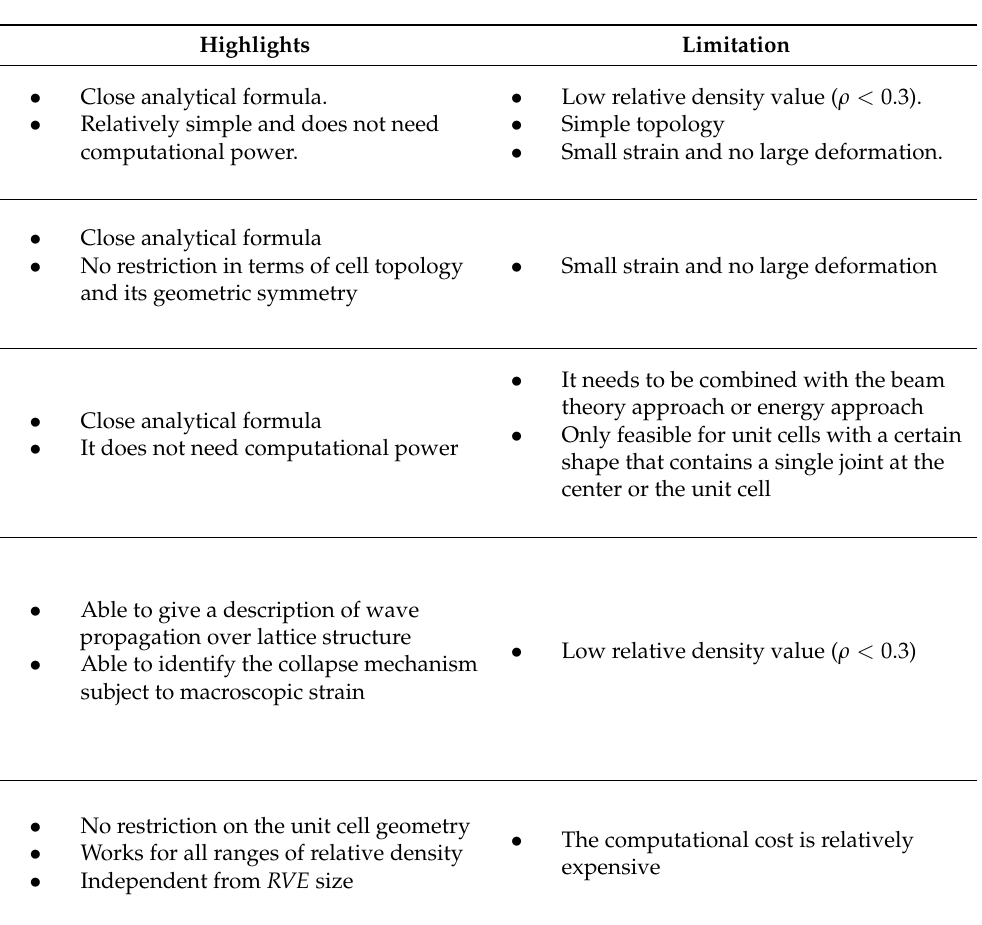
Table 1. Summary of Homogenization